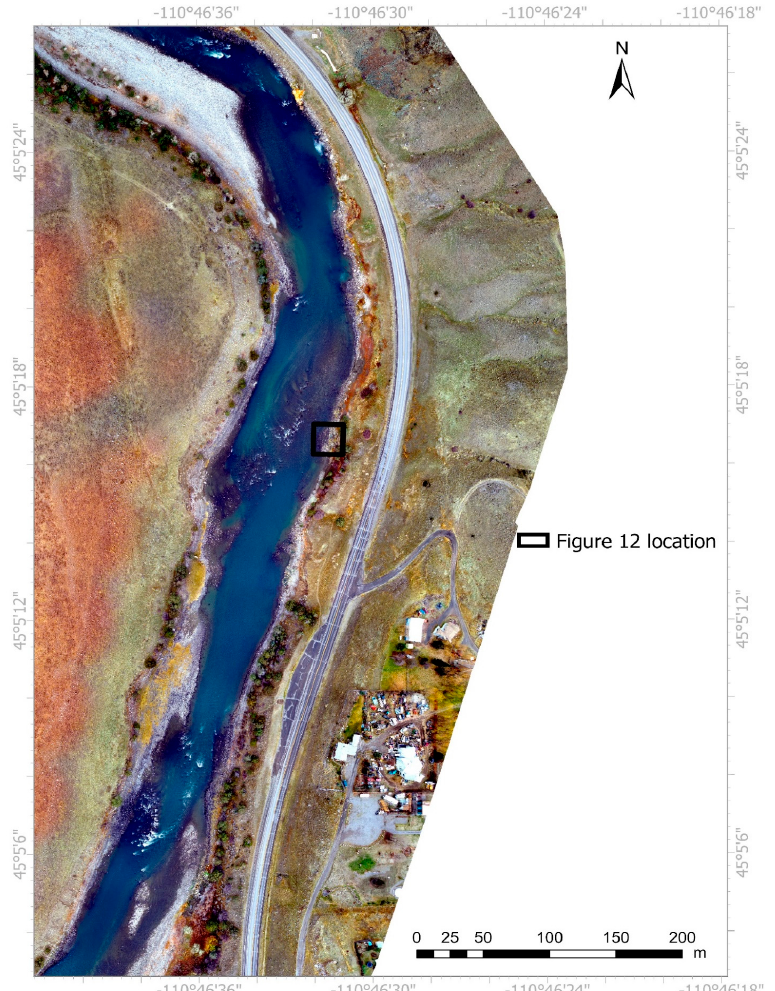
Figure A5. Study area RGB orthomosaic (November 2018) with Figure 12 location.